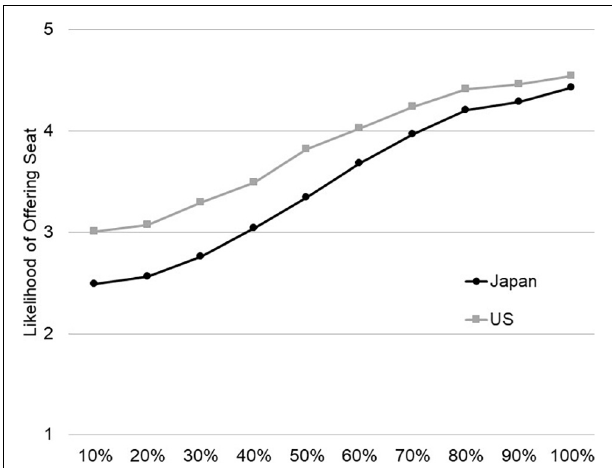
FIGURE 1 | Japanese are less likely than Americans to offer seat to a woman when the need for help is ambiguous, but the difference diminishes as the likelihood of the woman being pregnant increases from 10% certain to 100% certain (Study 2).